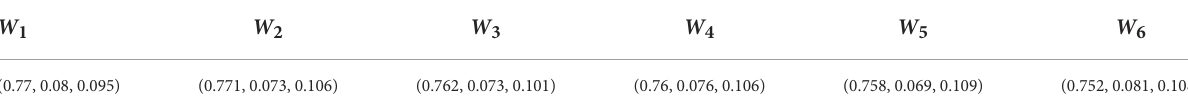
TABLE 6 The average PFN of each attribute.